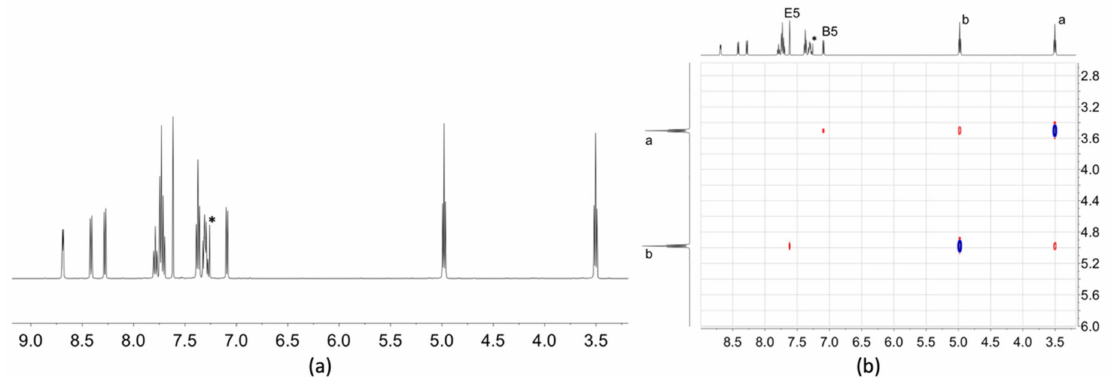
Figure 1. ( a ) The 1 H-NMR spectrum (500 MHz, CDCl 3 , 298 K) of compound 3 , and ( b ) part of the NOESY spectrum of 3 (500 MHz, CDCl 3 , 298 K). * = residual CHCl 3